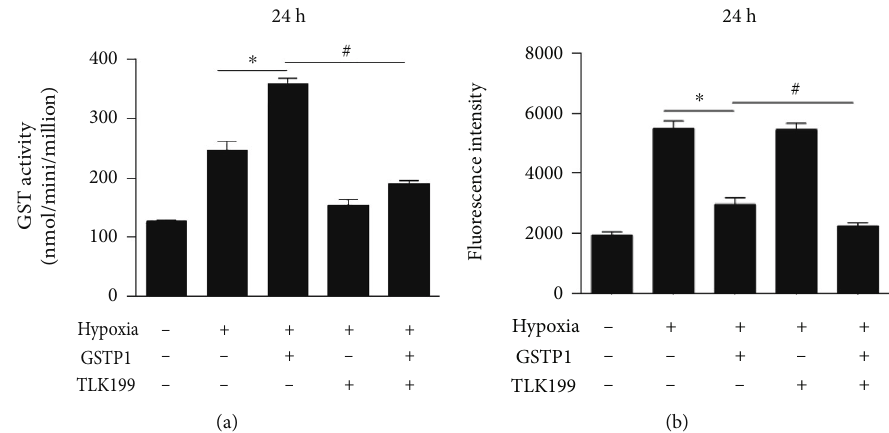
Figure 4: GSTP1 scavenged ROS accumulation. (a) After hypoxia exposure or TLK199 treatment, GST activity was measured quantitatively. * P < 0 : 05 , vs. hypoxia group; # P < 0 : 05 , vs. hypoxia/GSTP1 group. (b) ROS accumulation was measured. * P < 0 : 05 , vs. hypoxia group; # P < 0 : 05 , vs. hypoxia/GSTP1